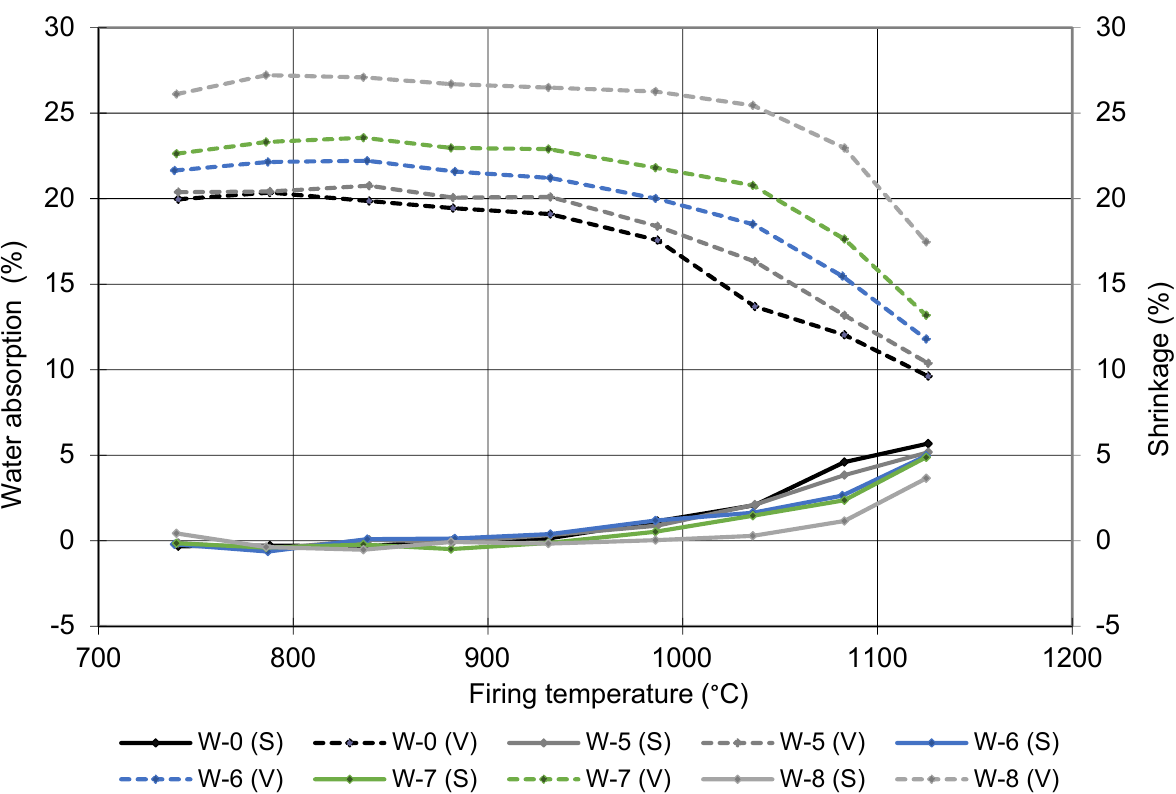
Figure 6. Shrinkage (S) and water absorption (V) independence of firing temperature. Comparing the XDR diffractograms of W0 and W8 after firing at 950 °C in Figure 7, we find that there are no major differences in mineralogical composition; mainly quartz present. Based on the chemical compositions (Table 2), it appears that additional peaks (at 28 ◦ ), which start to emerge in W8, could correspond to anorthite [36].